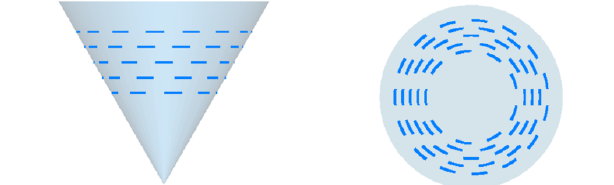
Fig. 12. Structure made of circumferential strips conformed on a cone: side (left panel) and top (right panel) views